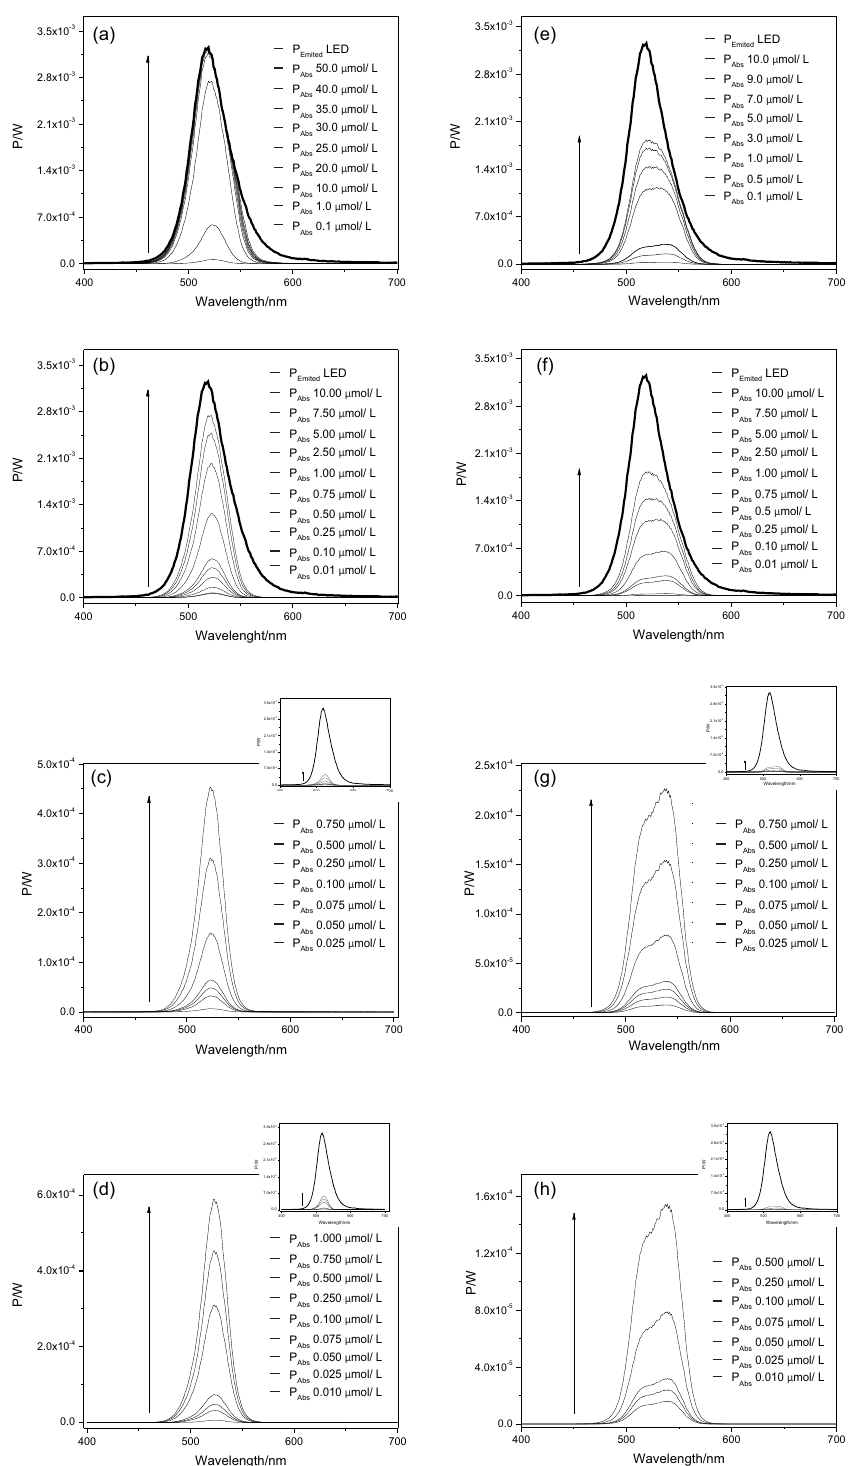
Figure 3. Spectra of light emitted by LED and power absorbed by ERY and RB for biofilm cells of E. coli ( a , e ), S. aureus ( b , f ), E. hirae ( c , g ) and L. innocua ( d , h ). The arrow indicates increase in photosensitizer concentration. The small chart displayed on the top-right side of figures ( c , d , g , h ) corresponds to its scaled-down